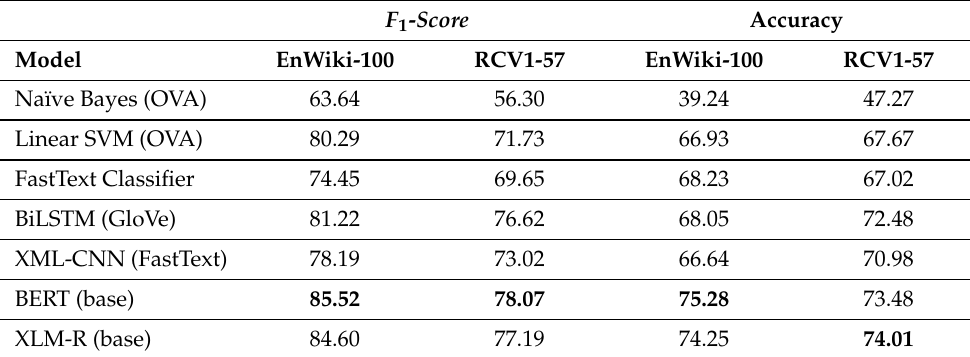
Table 7. Test set Macro- F 1 and Subset Accuracy (%) on synthesized datasets (best results in bold). F 1 -